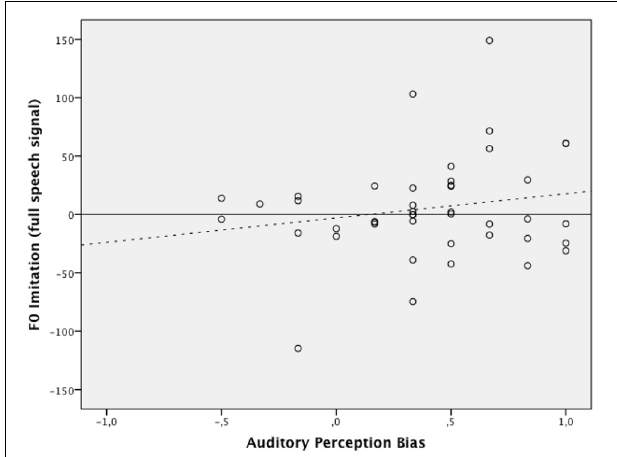
FIGURE 3 | The relation between auditory perception bias above 1000Hz and the degree of F 0 imitation in the condition with full speech signal (dotted line indicating trend). The x-axis represents the auditory perception bias expressed as δ p (1000). The y-axis expresses the difference between D 1 , the absolute difference between the model speaker’s F 0 and the participant’s F 0 in the first (baseline) block, and D 2 , the absolute difference between the model speaker’s F 0 and the participant’s F 0 in the second (first shadowing) block; a positive value here indicates imitation and a negative value indicate divergence.